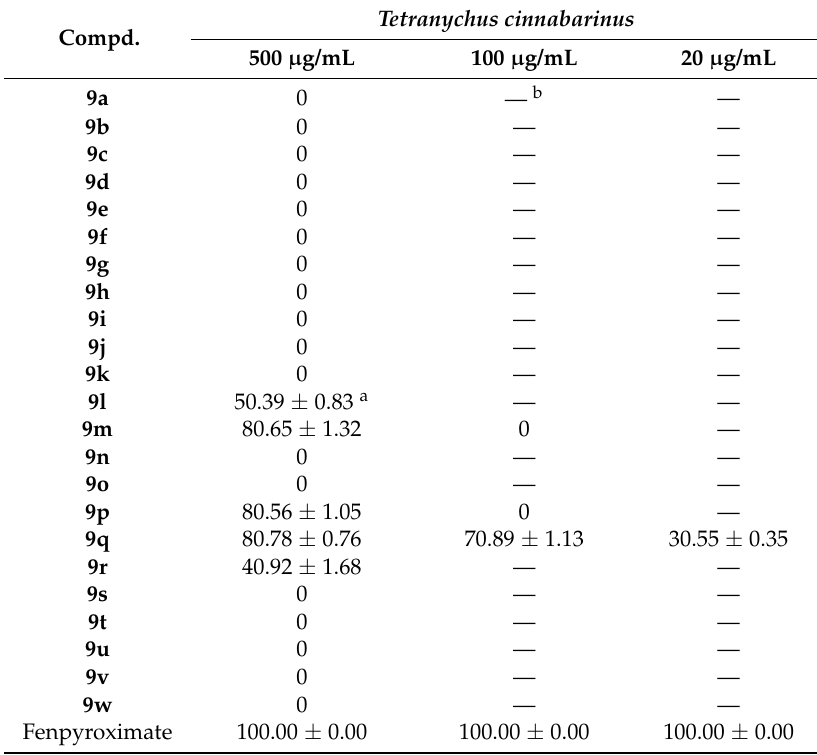
Table 1. Acaricidal activities of compounds 9a – 9w (mortality, %).